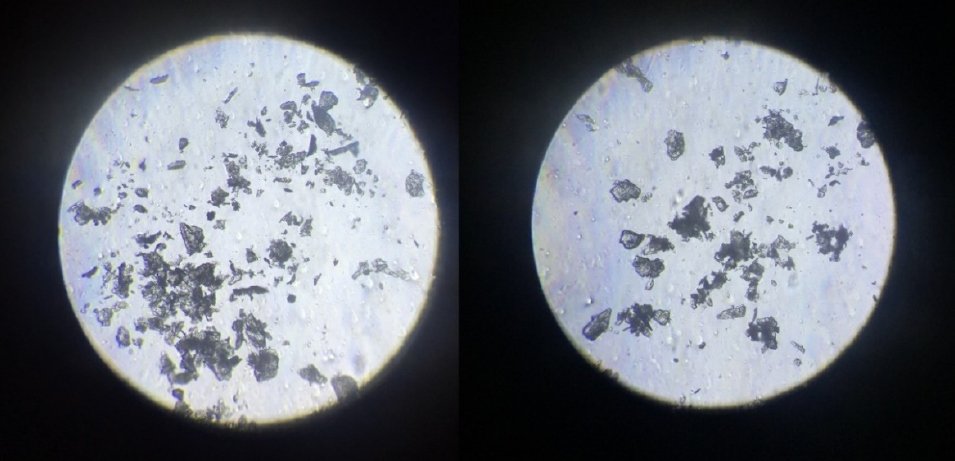
Figure 3. Two microscopic views of the pharmaceutical-grade talc used in the experiments (100× magnification by PZO Poland microscope; max. dimension of each view is 1 mm). The smaller talc particles have multiple sharp, fibrous edges; the larger ones form flat, crystalline structures, with a high tendency for conglomeration.